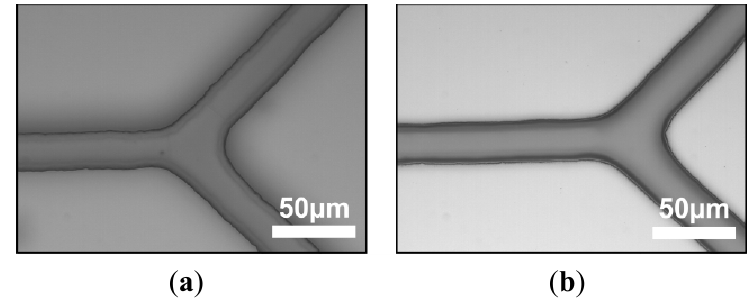
Figure 5. SU-8 Y-shape channel impressed with the same mask using ( a ) the mask aligner and ( b ) the UV Box (SU-8, thickness: 10